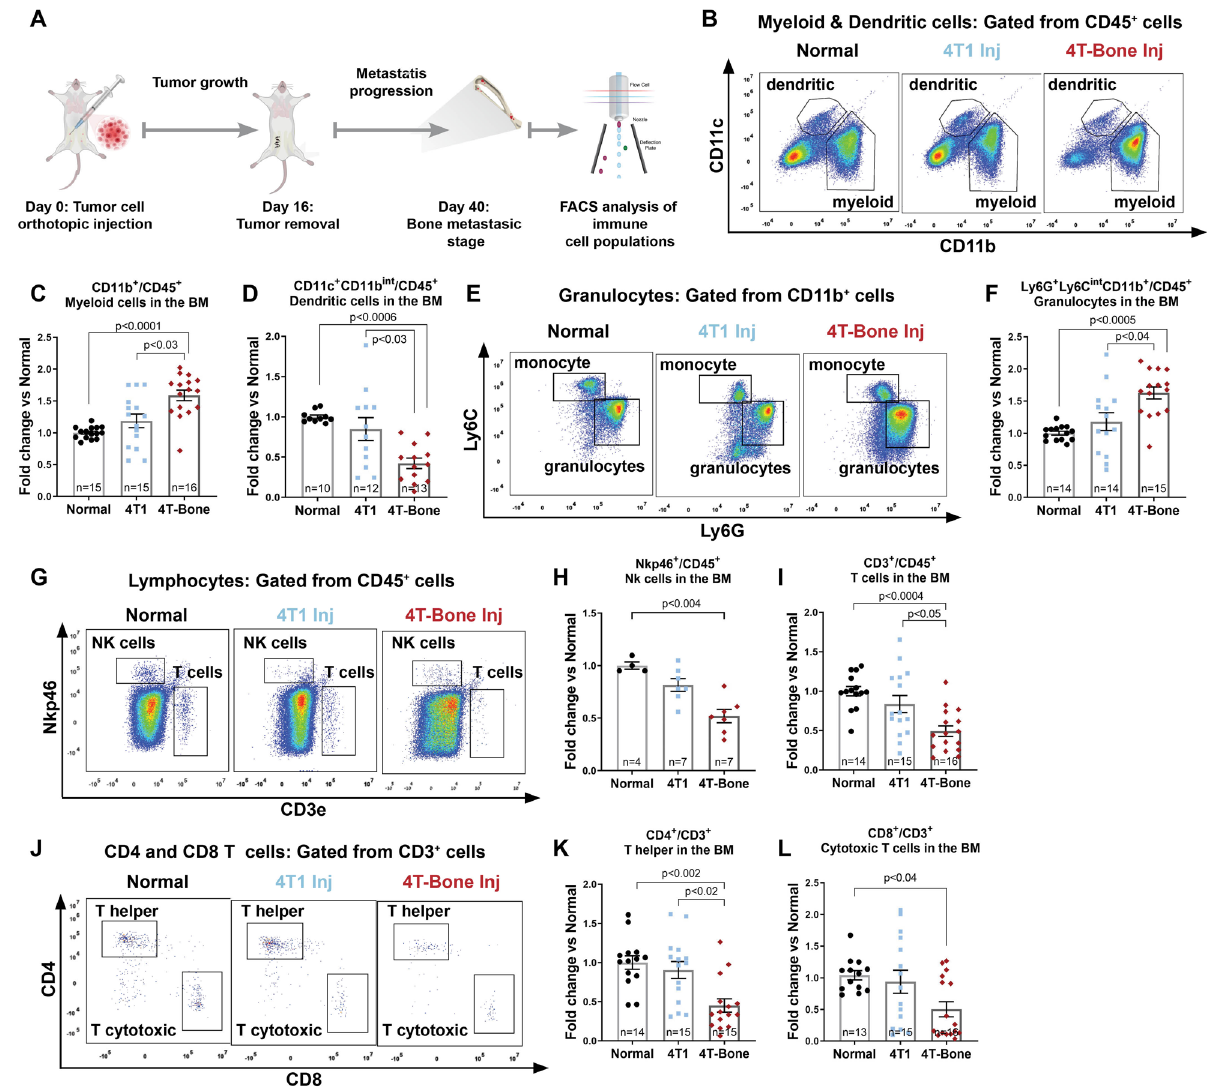
Figure 2. Bone metastases are associated with an immunosuppressive milieu. ( A ) Scheme of experimental design. Bone marrow of mice with bone metastases was flushed and the immune landscape was analyzed by flow cytometry. ( B – D ) Representative FACS gating and quantification of the total myeloid and dendritic compartment (CD45 + CD11b + /CD11c + ) for each group (normal, 4T1 or 4T-Bone injected mice). ( E , F ) Representative FACS gating and quantification of granulocytes (CD11b + Ly6G + Ly6C int ). ( G – I ) Representative FACS gating and quantification of T and NK cells within CD45 + cells. ( J – L ) Representative gating and quantification of T helper cells (CD3 + CD4 + ) and cytotoxic T cells (CD3 + CD8 + ). Number of mice per each group is specified in graphs. Data are presented as % of CD45 cells, normalized to the average of the normal group. Error bars represent SEM. p < 0.05; Kruskal–Wallis multiple comparison